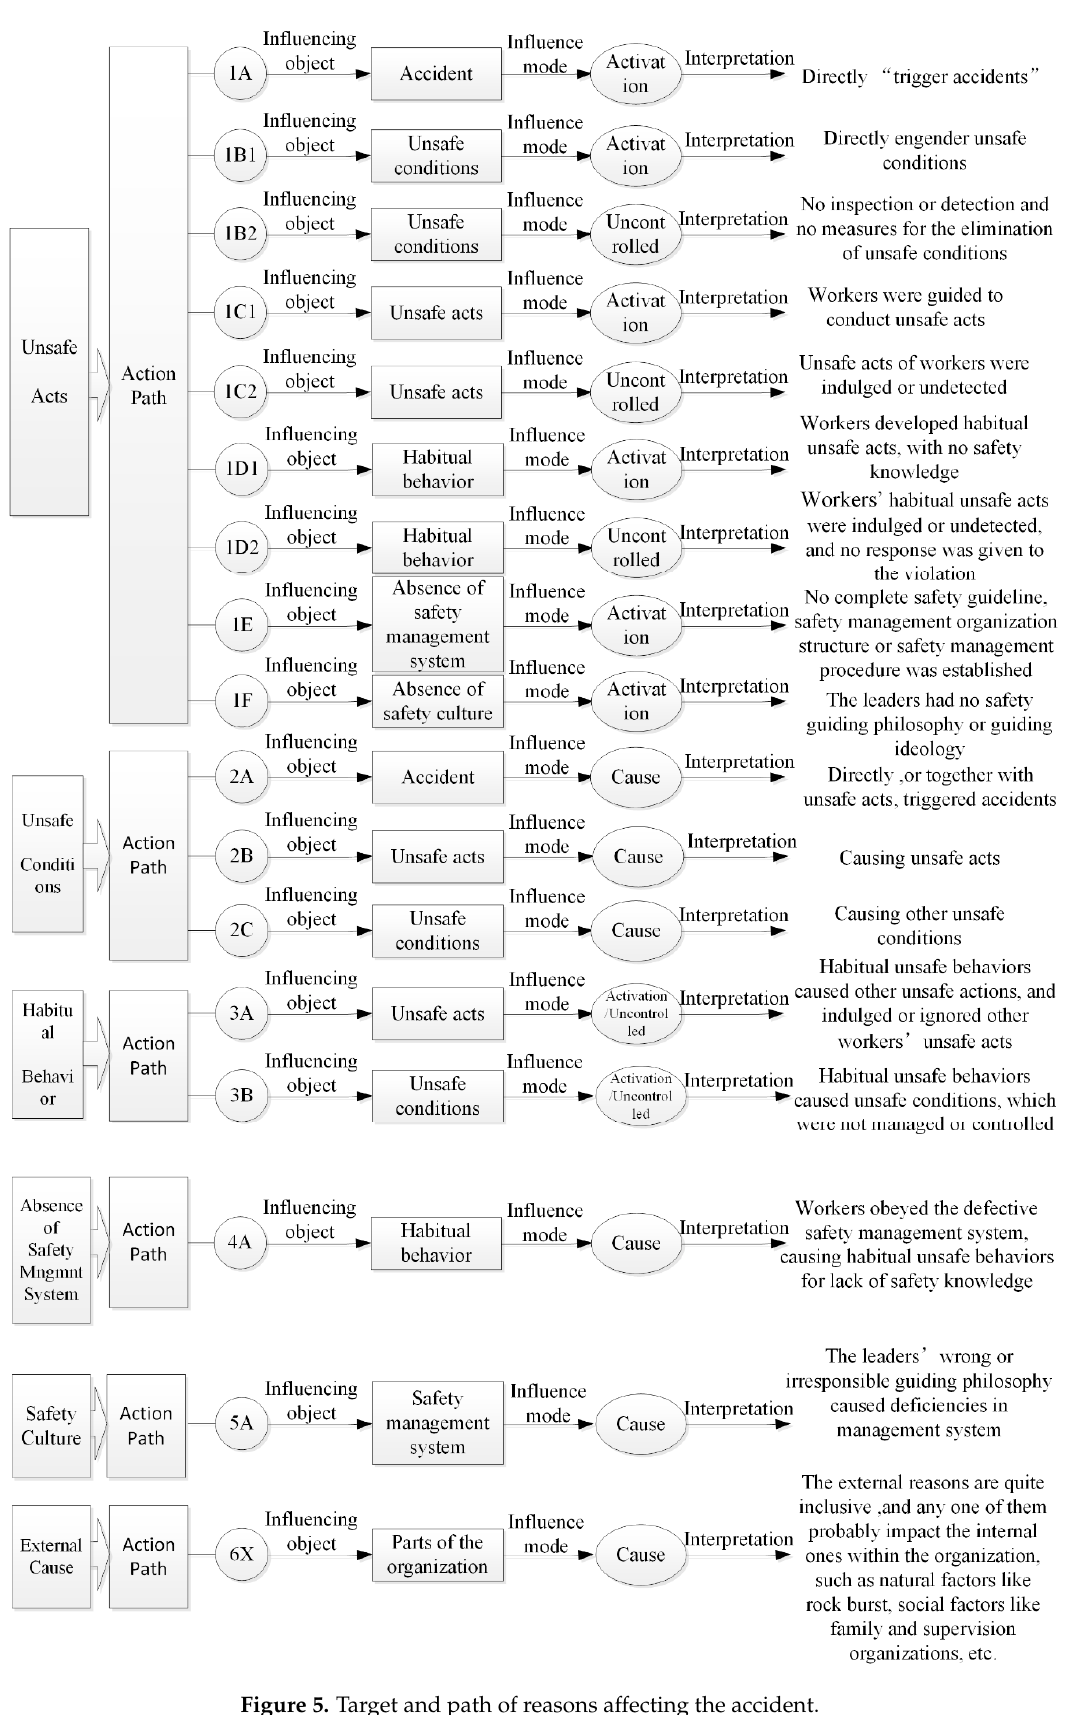
Figure 5. Target and path of reasons affecting the accident.